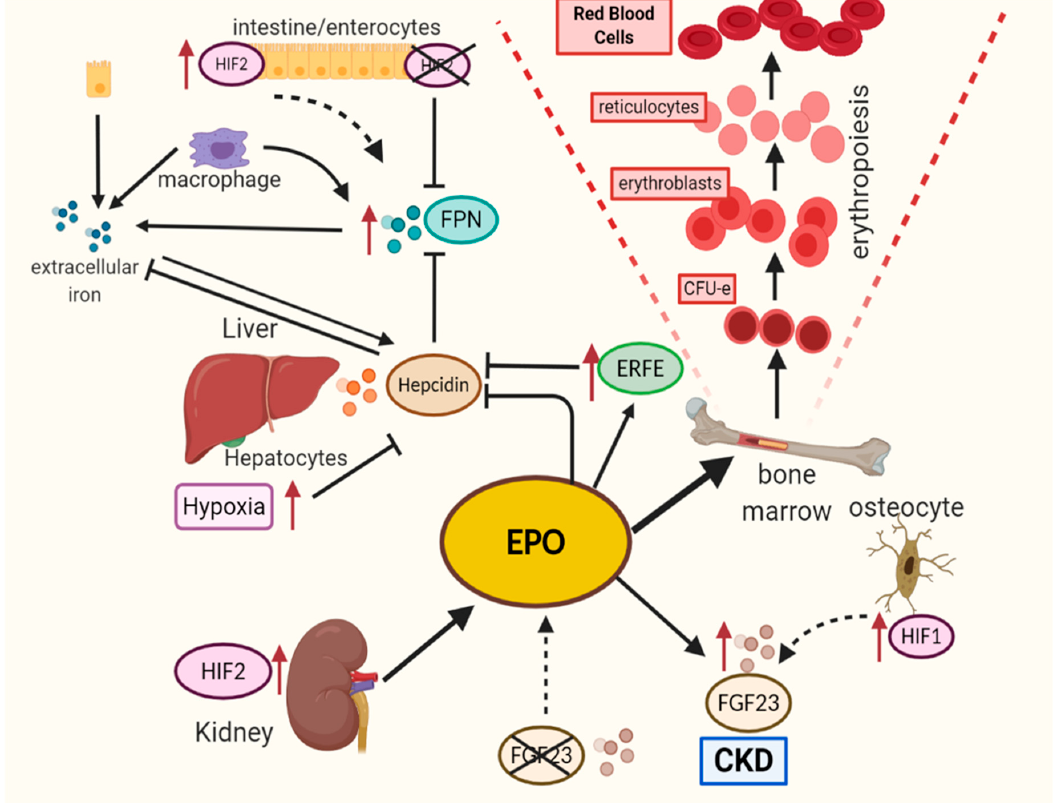
Figure 2. Hypoxia pathway proteins mediated regulation of erythropoiesis. EPO, the crucial